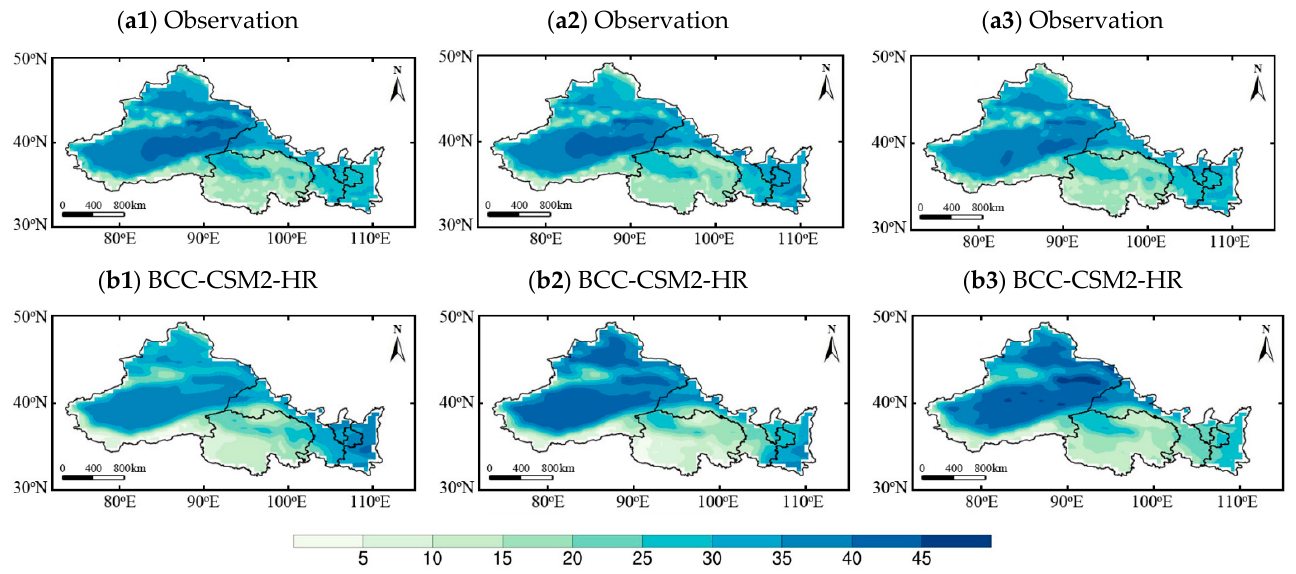
Figure 9. Distribution of extremely high temperatures in Event 1 ( left ), Event 2 ( middle ), and Event 3 ( right ) over Northwest China: observations and the values simulated by the BCC-CSM2-HR. Unit: °C.